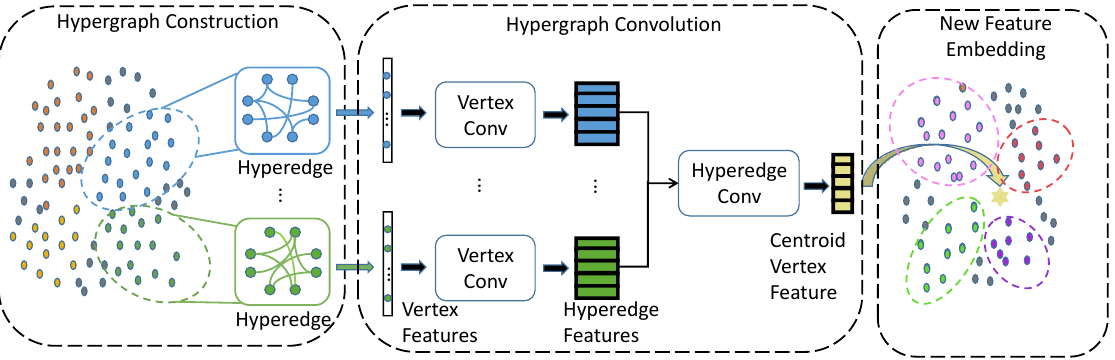
Figure 6. Structure of the dynamic hypergraph neural network model [69].